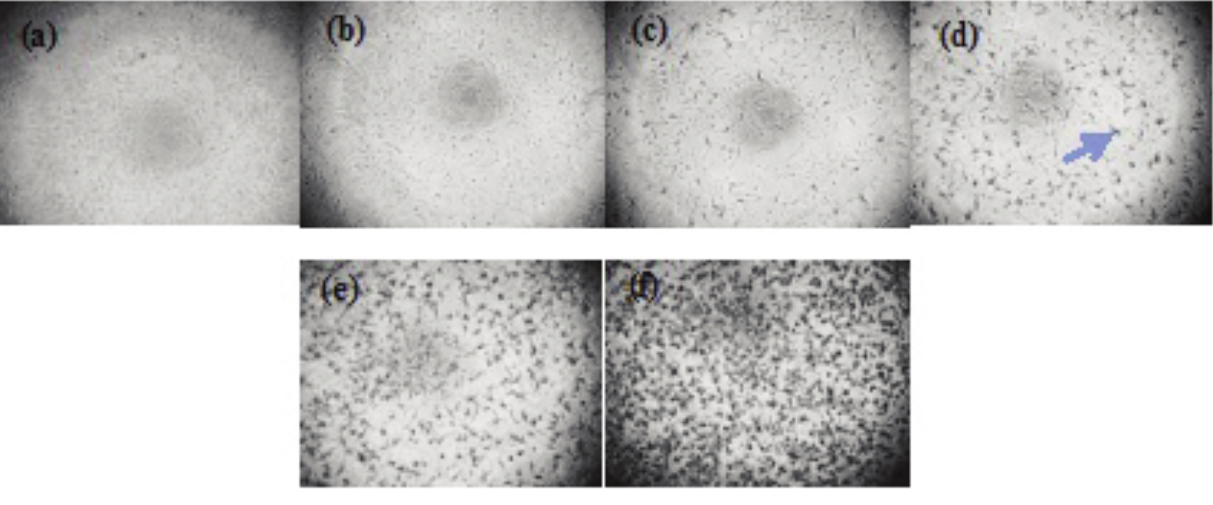
Figure 4. Vero cells conditions after treatment under microscope (40x). (a) normal Vero cells (control); (b) concentration 12.5 µg/mL; (c) concentration 25 µg/mL; (d) concentration 50 µg/mL; (e) concentration 100 µg/mL; and (f) concentration 200 µg/mL. The blue arrow shows apoptosis cell caused by interaction with complex